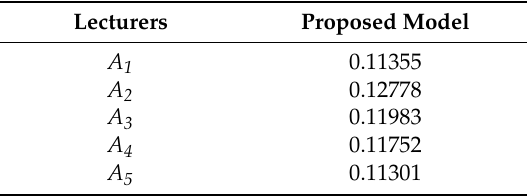
Table 5. The closeness coe ffi cient of lectures.